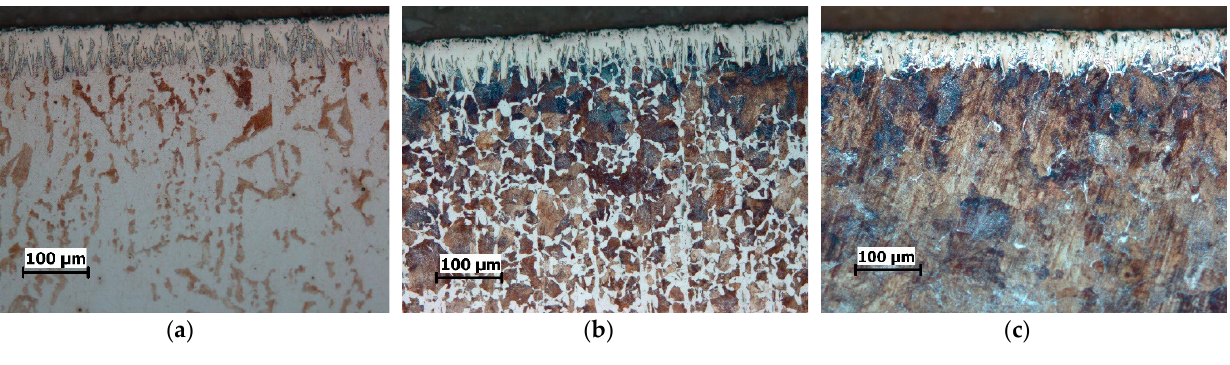
( c ) Figure 3. Microstructure of the boride layers obtained by boronizing at 870 °C for 8 h, magnification 200:1: ( a ) C15 steel; ( b ) C45 steel; ( c ) C70W2 steel. ( a ) ( b ) ( c ) Figure 4. Microstructure of the boride layers obtained by boronizing at 970 °C for 4 h, magnification 200:1: ( a ) C15 steel; ( b ) C45 steel; ( c ) C70W2 steel. In addition, porosity can be seen on the surface of the layers, which is more pro- nounced at higher temperatures. Darker sections within the diffusion zone, directly below the layer, can be observed in all three steels, and represent an increased carbide content compared to the core. 3.2. Boride Layer Growth Kinetics 3.2.1. Results from Previous Studies As mentioned above, the objective of the present study was to develop a diffusion model that takes into account not only the boronizing parameters but also the chemical composition of the treated steel. To achieve this, the results from earlier studies [43–45] were used as input data for a new, additional investigation conducted within this study.